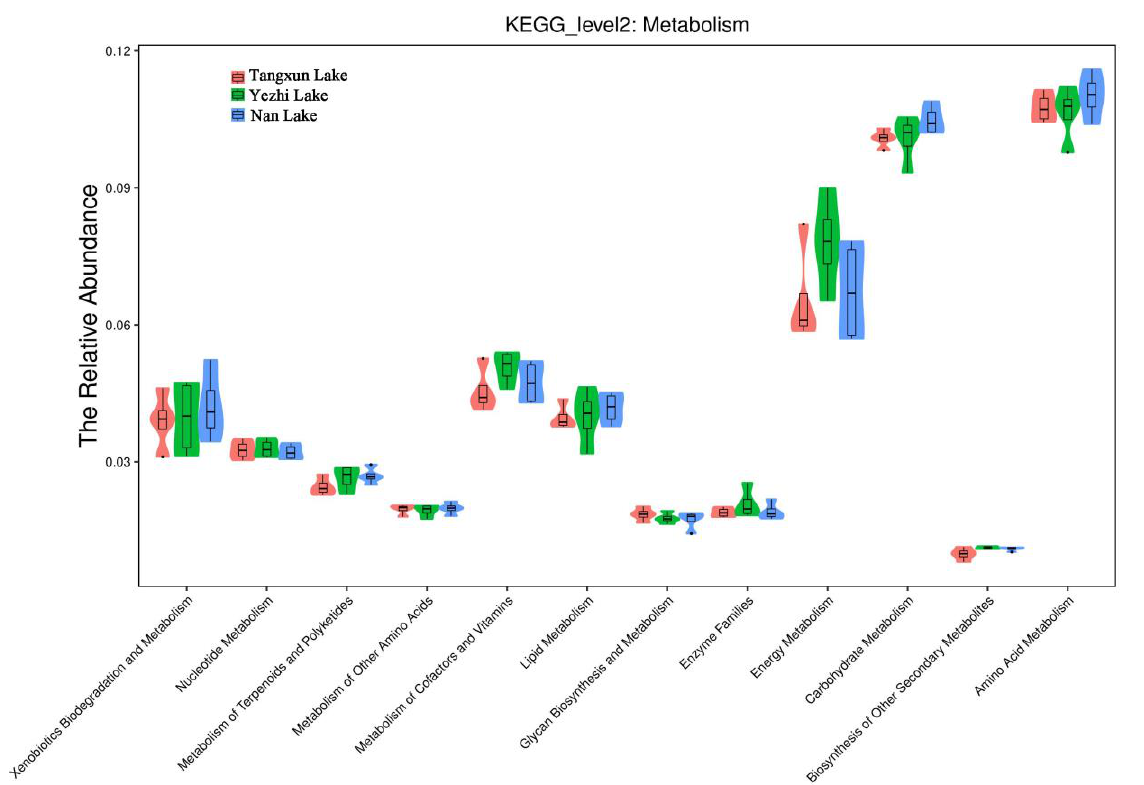
Figure 5. Function prediction of bacterial taxa based on the second level KEGG module by PICRUSt.